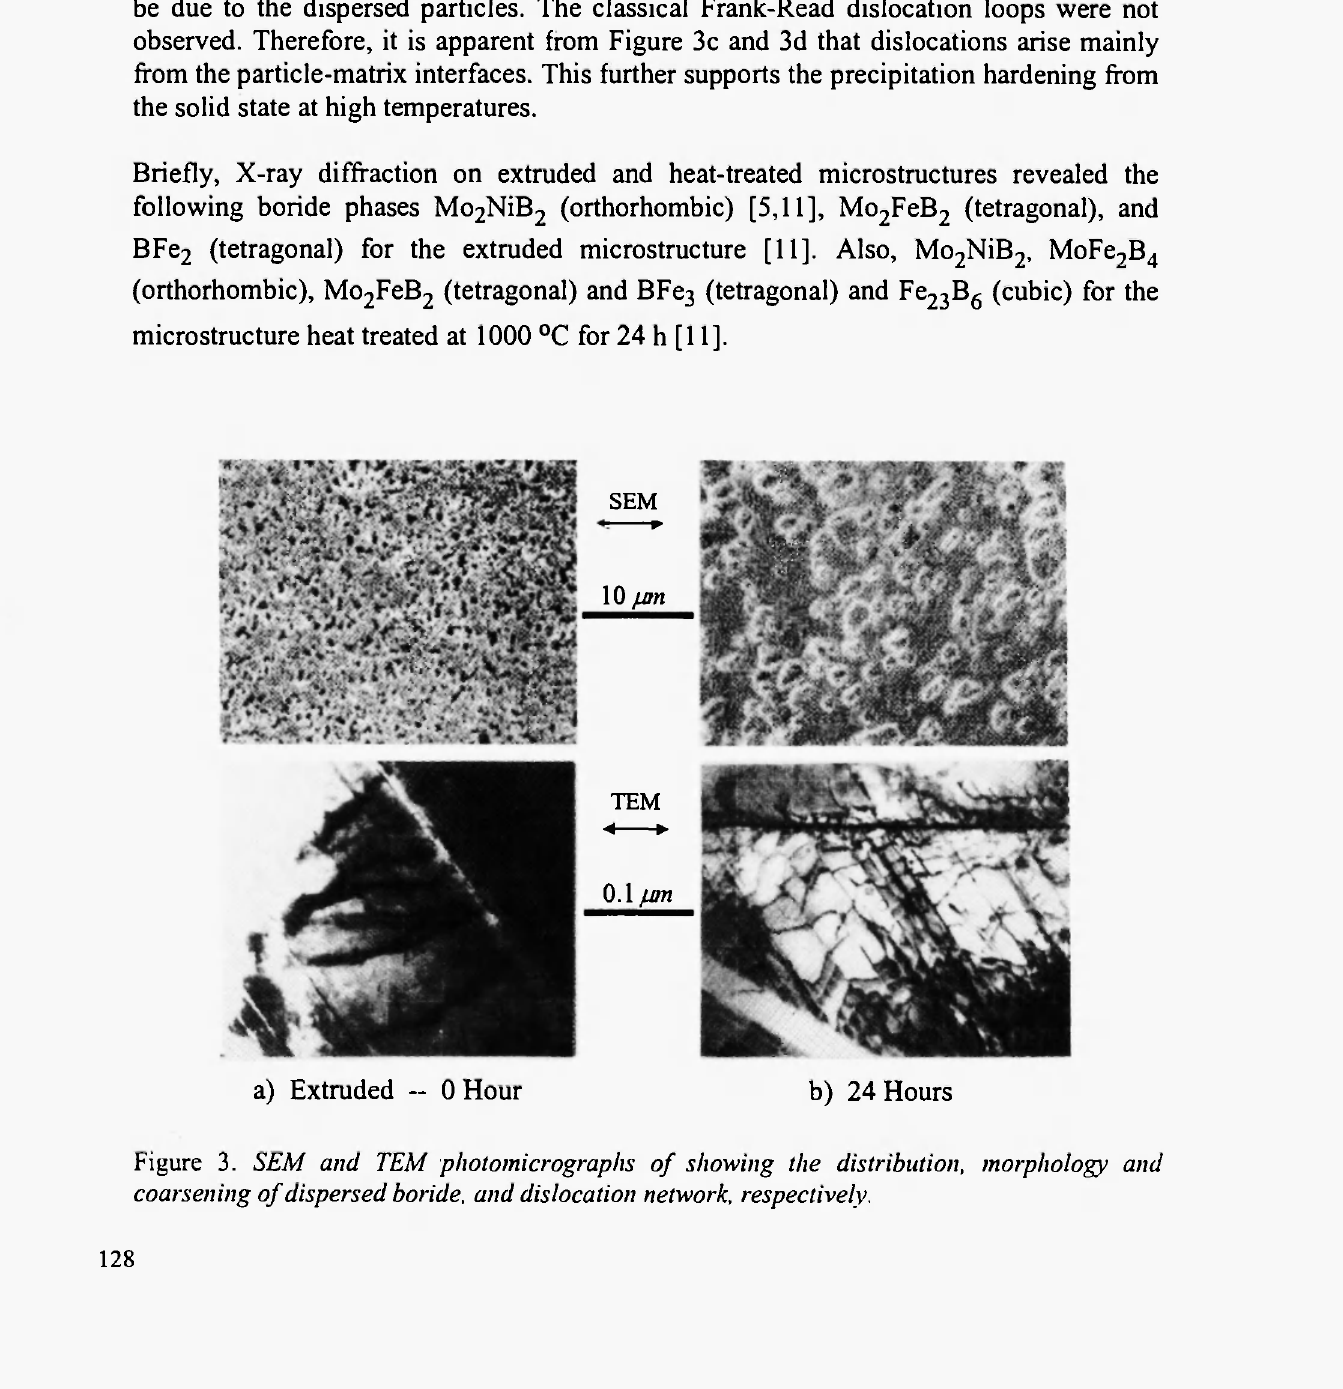
Figure 3. SEM and TEM photomicrographs of showing the distribution, morphology and coarsening of dispersed boride, and dislocation network,